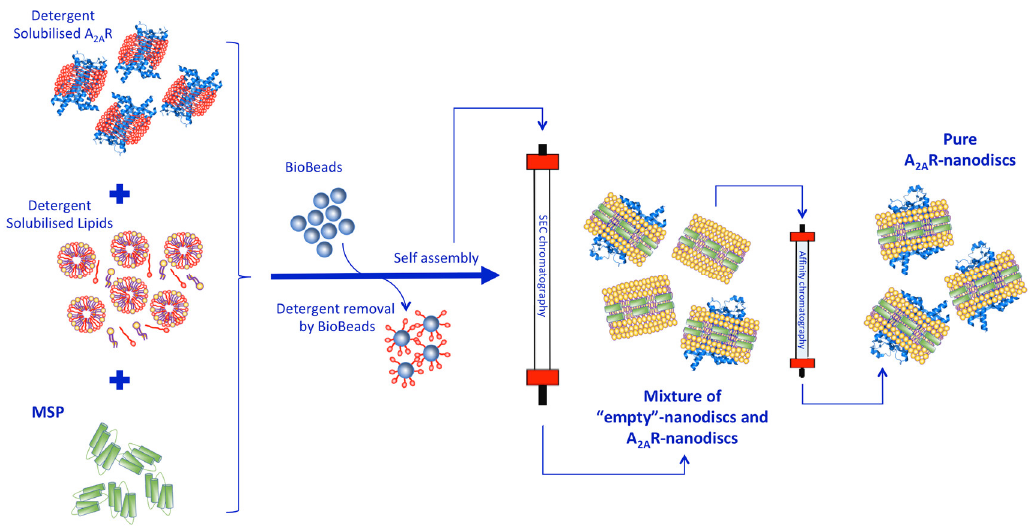
Figure 2. Cartoon representation of a standard nanodisc assembly protocol. Detergent-solubilised membrane protein (A 2A R) is incubated with the membrane sca ff old protein (MSP) and the lipid–detergent mixture at the target concentration ratio. Following, Biobeads are added to the mixture to remove detergent and initiate nanodiscs’ assembly. Traditionally, size exclusion chromatography (SEC) is performed to assess the disc formation and if successful, a ffi nity chromatography is executed to remove the nanodisc particles that are bare. Detergent molecules are represented in red, lipids in yellow, protein receptor in blue and membrane sca ff old protein in